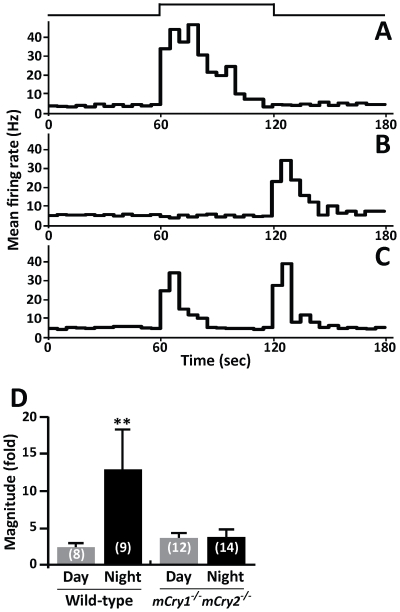
Reduced light response of neuronal firing activity in the optic nerve fibers of mCry1−/− mCry2−/− mice.
A, B, and C, Peristimulus time histograms of three distinct response patterns were recorded: ON fibers, which respond to light onset (A), OFF fibers, which respond to light offset (B), and ON/OFF fibers, which respond to both light onset and offset (C). The mean firing rate per second (Hz) is plotted every 5 min in the histogram. Light intensity was 1.0×1015 photons·cm−2·s−1 for 60 sec. The timing of the light pulse is indicated in the step diagram above the records. D, The magnitude of change in the discharge rate for retinal illumination recorded in the ON fiber. Histograms depict data as mean ± SEM; the number of animals is shown in parentheses. **P<0.01 vs. others, Tukey's test.